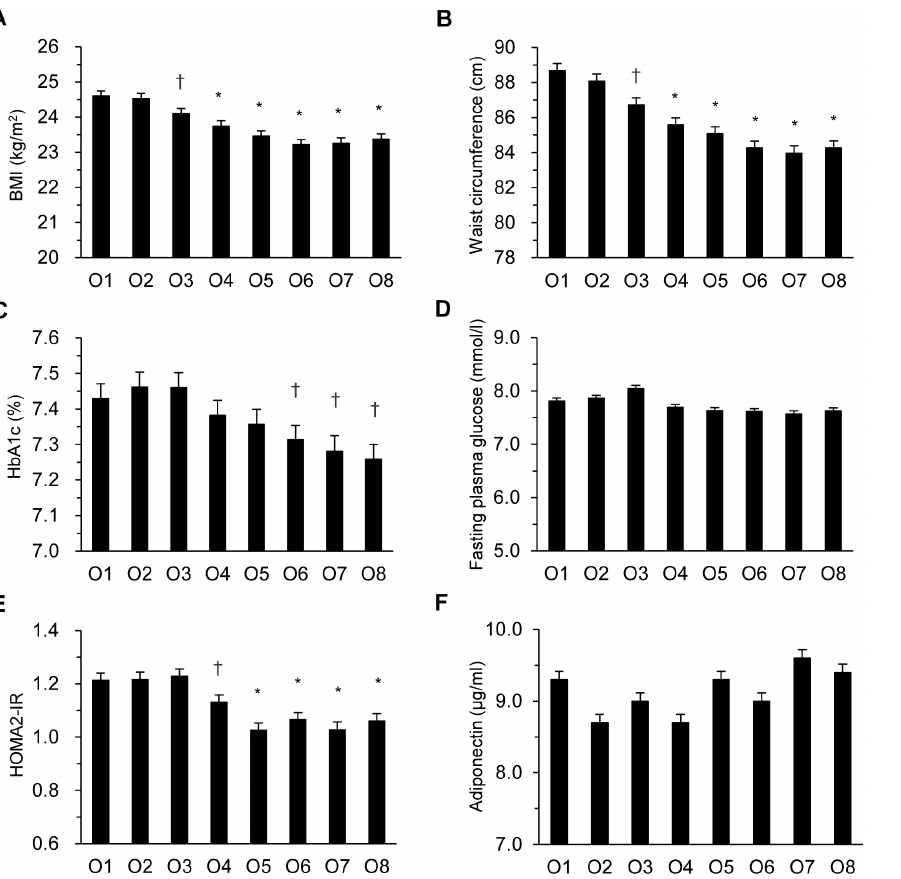
Figure 1. Changes in cardiovascular risk factors according to the octile of total leisure-time physical activity in Japanese type 2 diabetes patients. Age- and sex-adjusted body mass index (BMI) (A), waist circumference (B), hemoglobin A 1c (HbA 1c ) (C), fasting plasma glucose (D), homeostasis model assessment 2 of insulin resistance (HOMA2-IR) (E), and adiponectin (F) in the octile of T-LTPA in 4,870 Japanese type 2 diabetic patients. + p , 0.05, *p , 0.01 vs. the lowest O1.